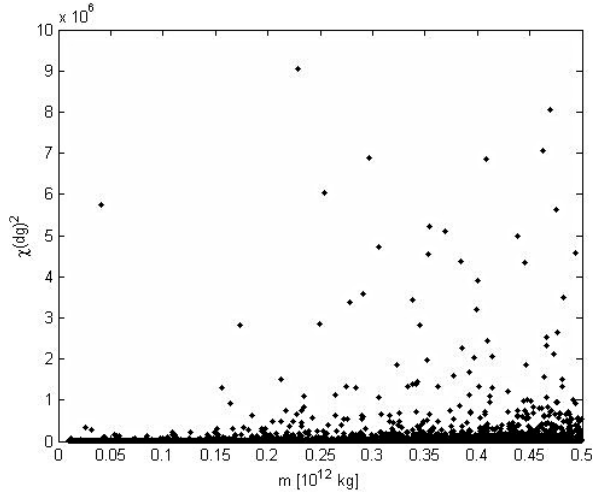
Fig. 3. χ( comp ) 2 distribution against the mass component m rela- tive to the 28645 Monte Carlo samples.